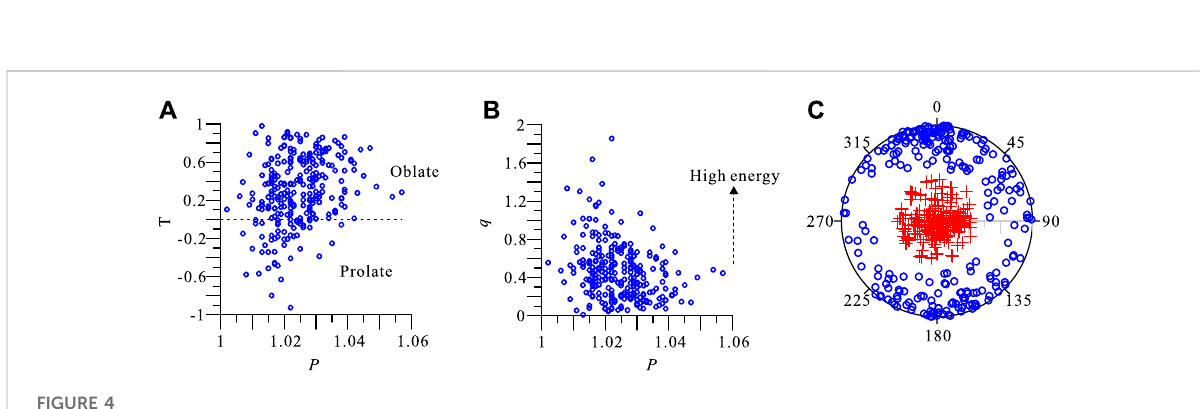
FIGURE 4 Projection of the magnetic fabric parameters of the shape factor (T)-degree of anisotropy ( P ) (A) and shape factor ( q) - P (B)